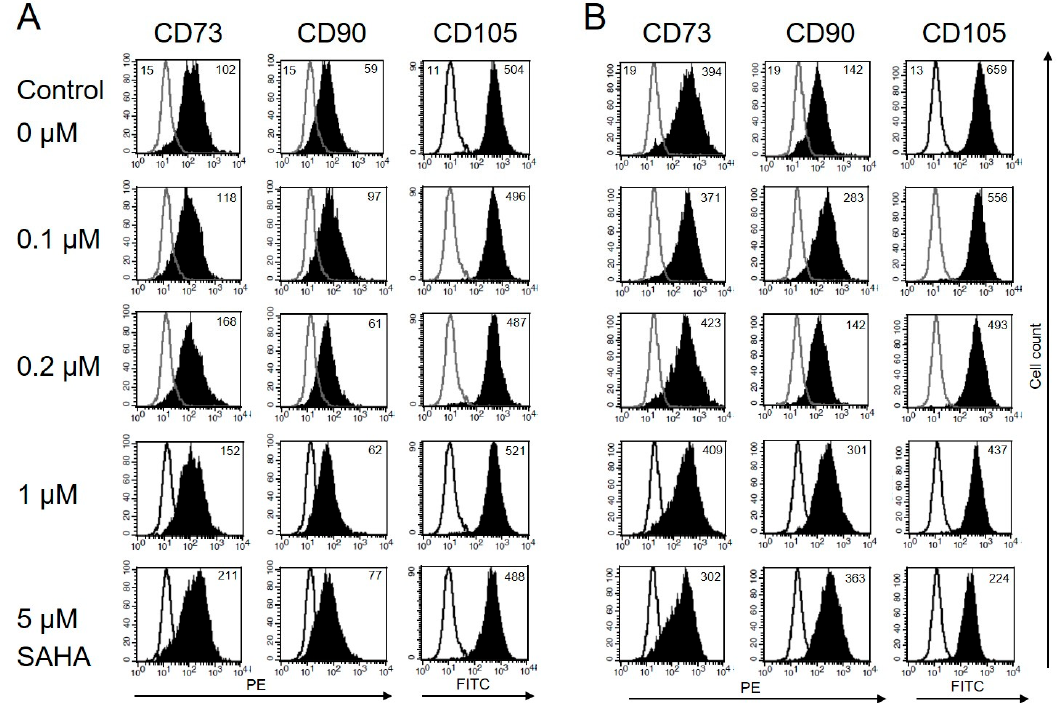
Figure 3. Immune phenotype of MSC is not markedly affected by SAHA treatment. ( A ) Flow cytometric analysis of cell surface markers on T-MSC. T-MSC were treated with SAHA for two days. Isotype controls are depicted in solid lines, and CD73, CD90, and CD105 stainings are depicted in filled histograms. Numbers show the mean fluorescence intensity (MFI). The expression of the surface marker CD73 moderately increased with increasing SAHA concentrations. Expression of CD90 and CD105 was not markedly affected. ( B ) BM-MSC showed an increased expression of CD90, a reduced expression of CD105 with increasing SAHA concentrations, and an unaltered expression of CD73 up to 1 μ M SAHA. SAHA: suberoylanilide hydroxamic acid.